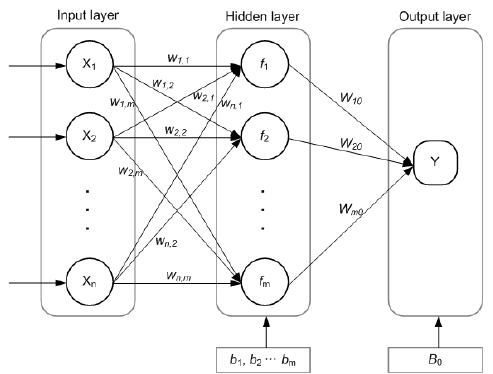
Figure 3. Conceptual diagram of the artificial neural network model [48].